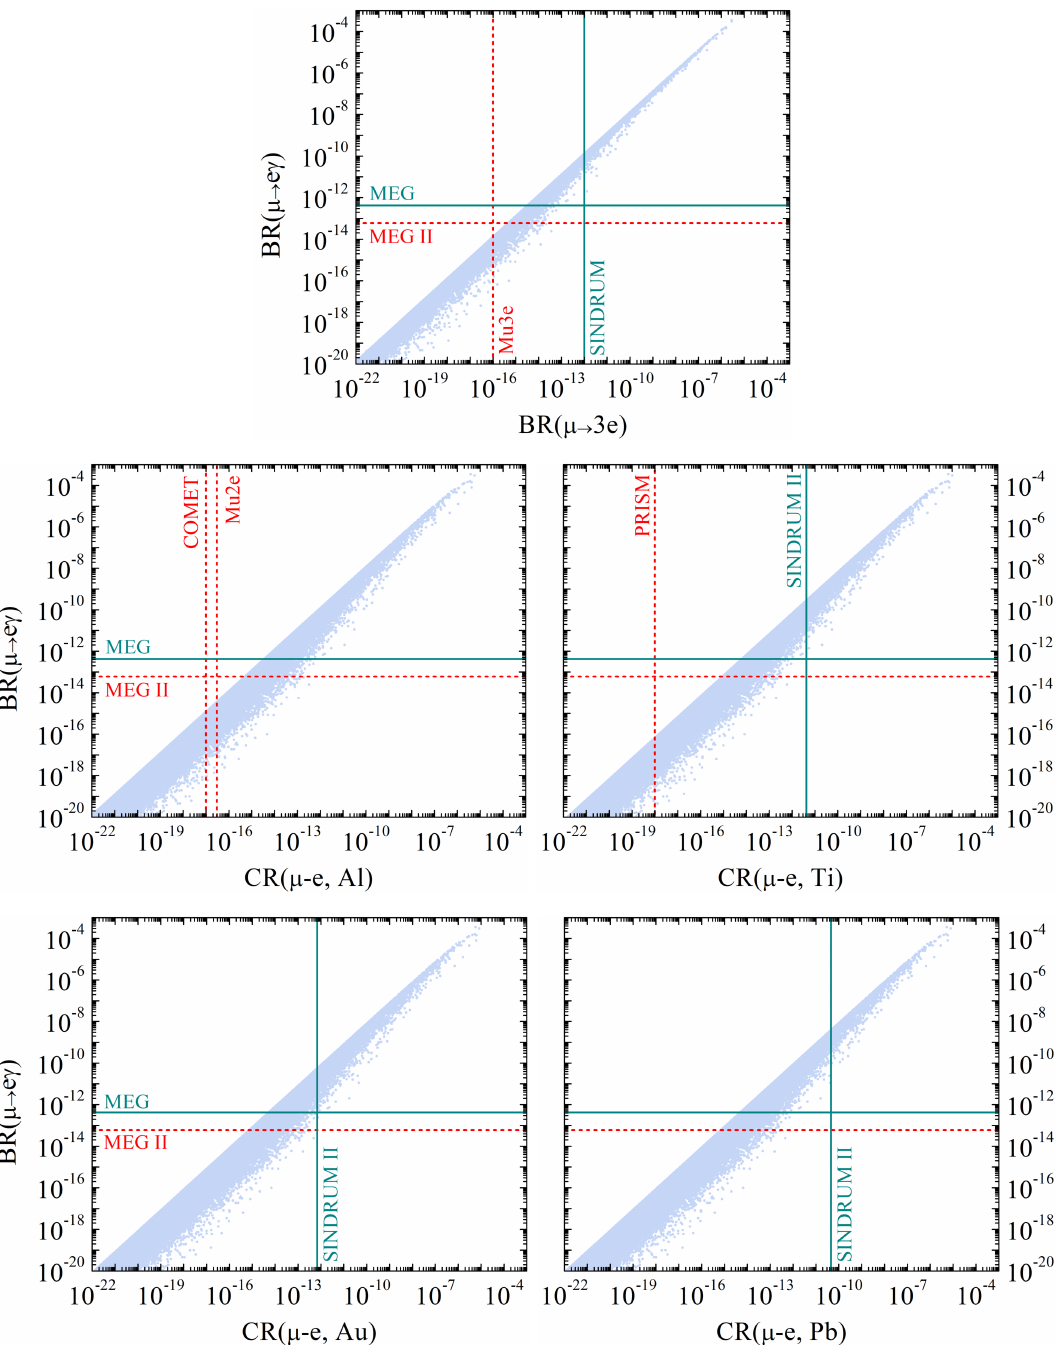
(B ) case. Namely, 4 8